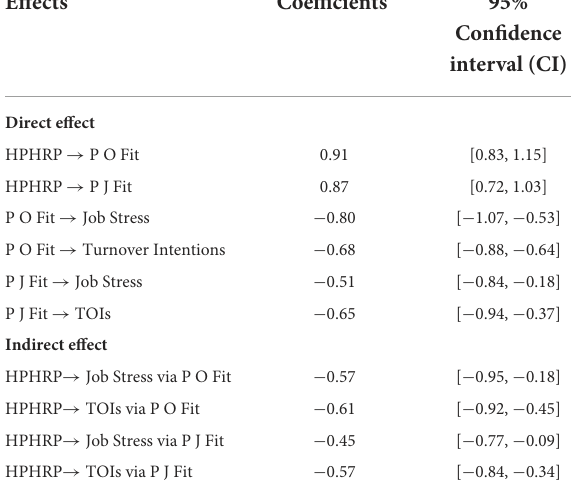
TABLE 2 Mediation